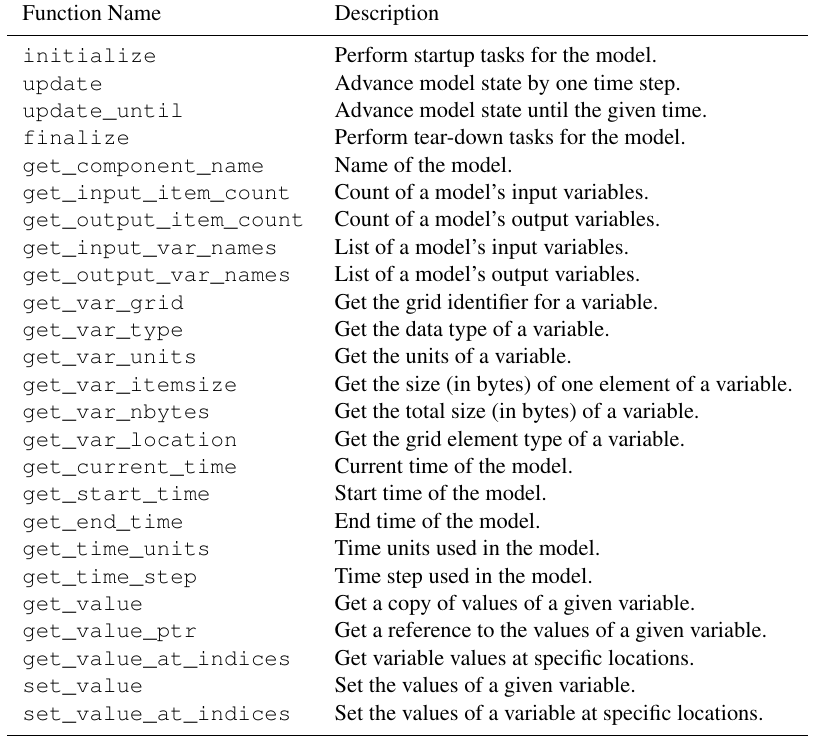
Table 1. Listing and description of Basic Model Interface (BMI) functions for run control and data access.